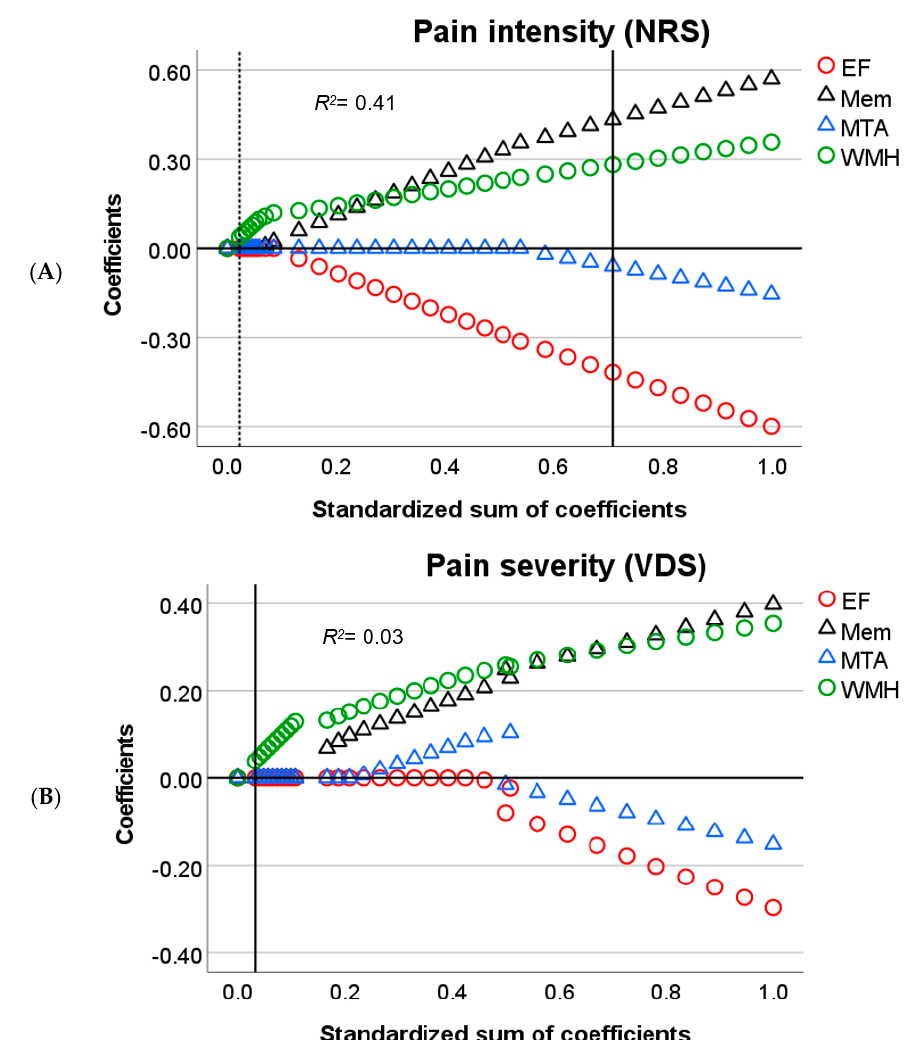
Figure 4. Output charts Lasso regression (Model 2). Input predictors are displayed in alphabetical order but were introduced as follows: executive function (EF), memory (Mem), white matter hyper- intensities (WMH), and medial temporal atrophy (MTA). Identified predictors and the respective dependent variables are: ( A ) EF, Mem, WMH, and MTA as predictors of pain intensity by NRS; and ( B ) WMH as a predictor of pain severity by VDS. Lasso coefficients (colored shapes) represent pos- itively and negatively related predictors above and below zero, respectively (y–axis). Shapes repre- sent variables that in their relations with pain can be visually compared against each other, i.e., the association between pain and EF partially explained by WMH (circles) and the association between pain and memory partially explained by MTA (triangles). These explanatory findings must be vis- ually seen by comparing coefficients against Figure 2. Vertical lines intersect the Lasso coefficients ( ≠ 0) from the most parsimonious predictors (dotted line) and the optimal predictors (solid line) as computed in the different models (these lines might coincide). In each subfigure, the values of the x–axis represent the relative influence of all the parameters over the dependent variable before shrinkage (standardized sum of coefficients = 1.0 minus shrinkage = 0, which is equal to 1.0 on the right side). At each stage of shrinkage (increasing from right to left in the x–axis), a higher penalty is added until the standardized sum of coefficients is at its lowest (i.e., 0) and shrinkage is at its highest (i.e., 1.0). The smallest prediction error is represented by the solid line tangential to the cor- responding shrinkage stage. The predictors with still meaningful associations ( ≠ 0) at such a stage are considered optimal predictors with Lasso coefficients marked in the y–axis. Regularization-R 2 is displayed on the top-left corner of the plots. Additional abbreviations: NRS = numerical rating scale, VDS = verbal descriptor scale.